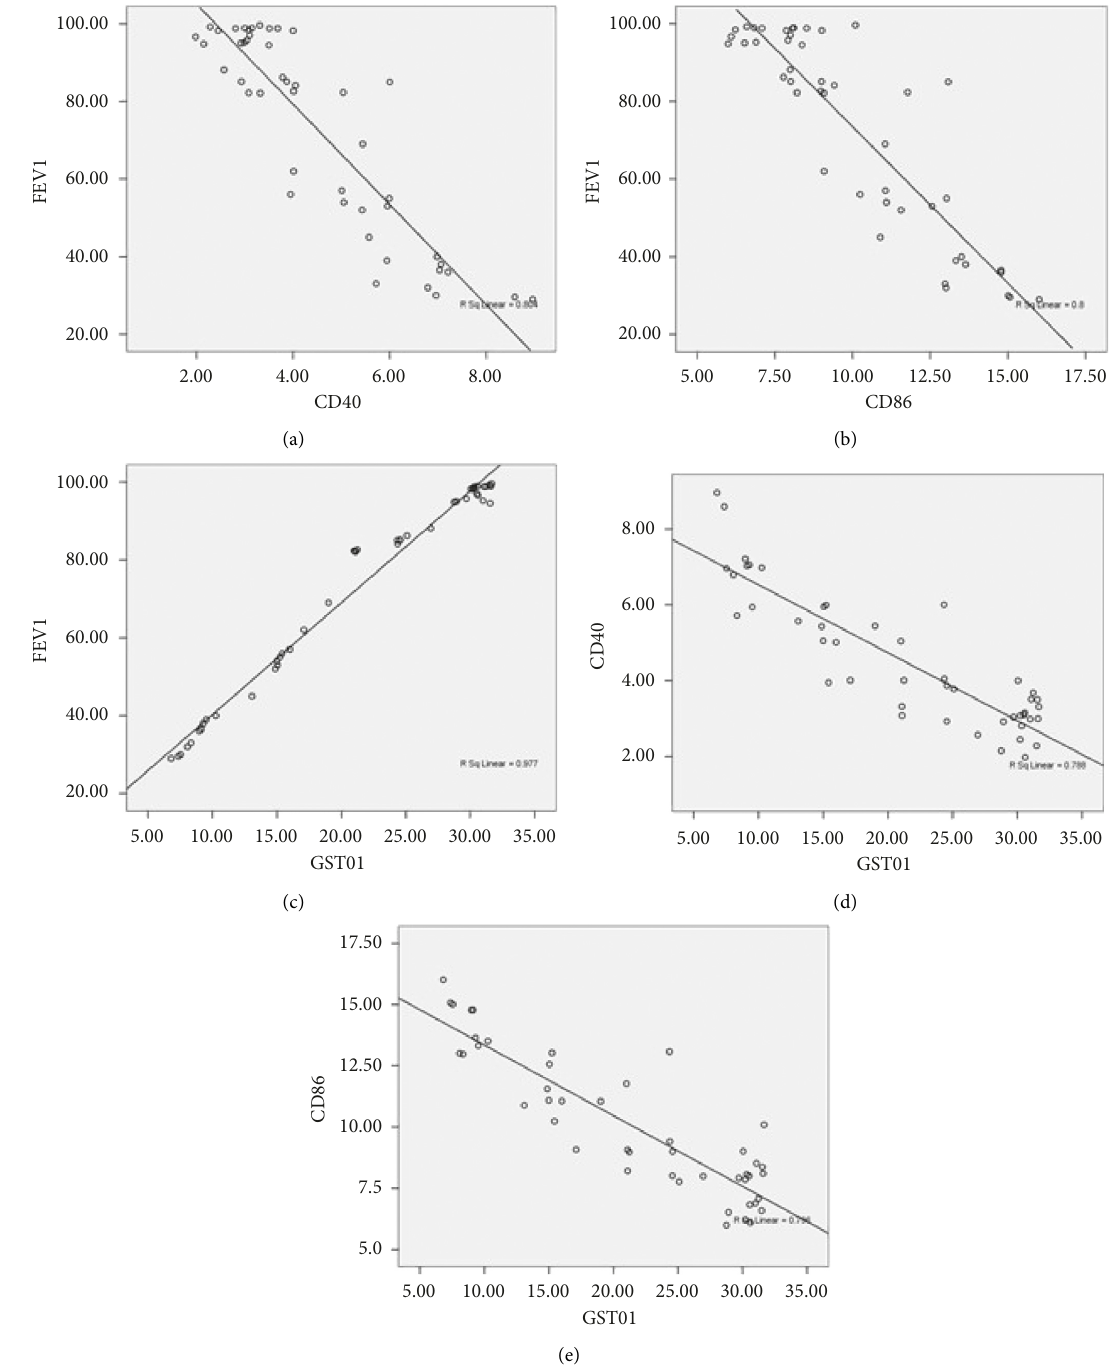
Figure 3: The correlation between CD40, CD86, and GSTO1 and their correlation with FEV1%, respectively. Correlations between FEV1% and CD40 (a) or CD86 (b). (c) Correlations between GSTO1 and FEV1%. Correlations between GSTO1 and CD40 (d) or CD86